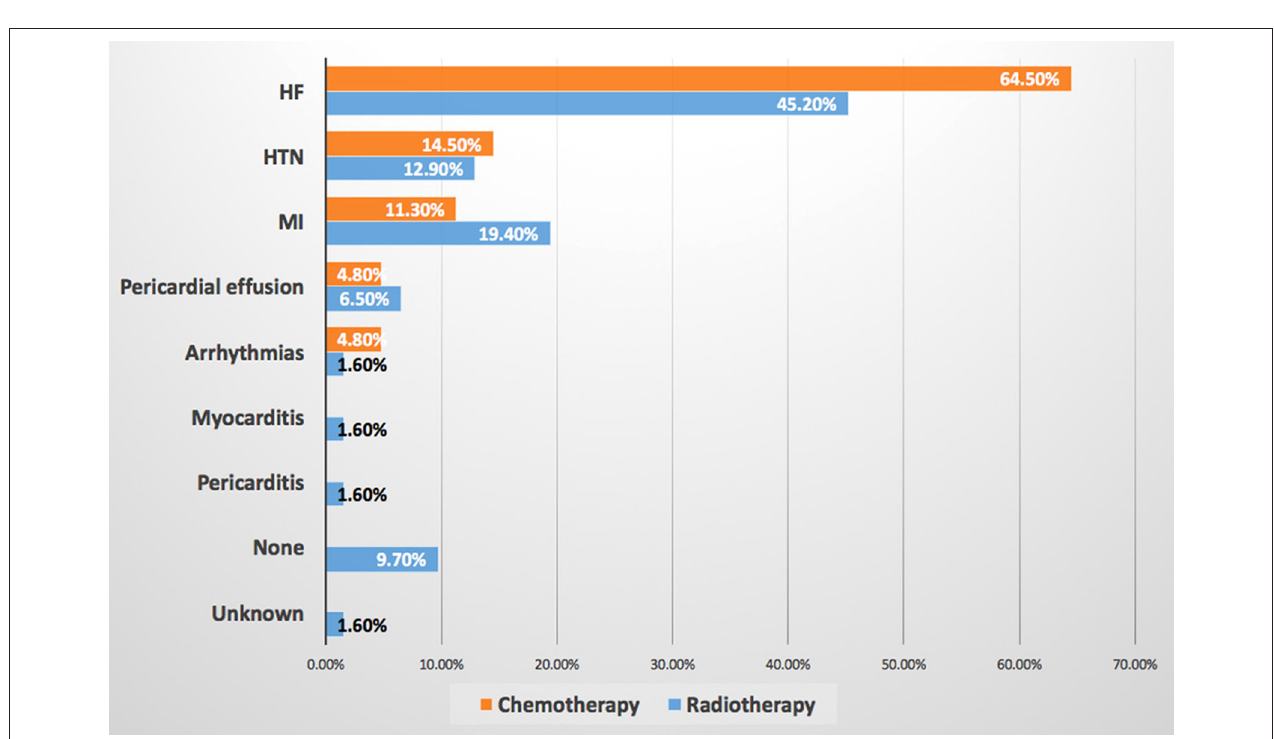
FIGURE 4 | Most common cardiovascular disease induced by chemotherapy and radiotherapy. HF is the most common CVD induced by both chemotherapy and radiation therapy. HF, heart failure; HTN, hypertension; MI, myocardial infarction.